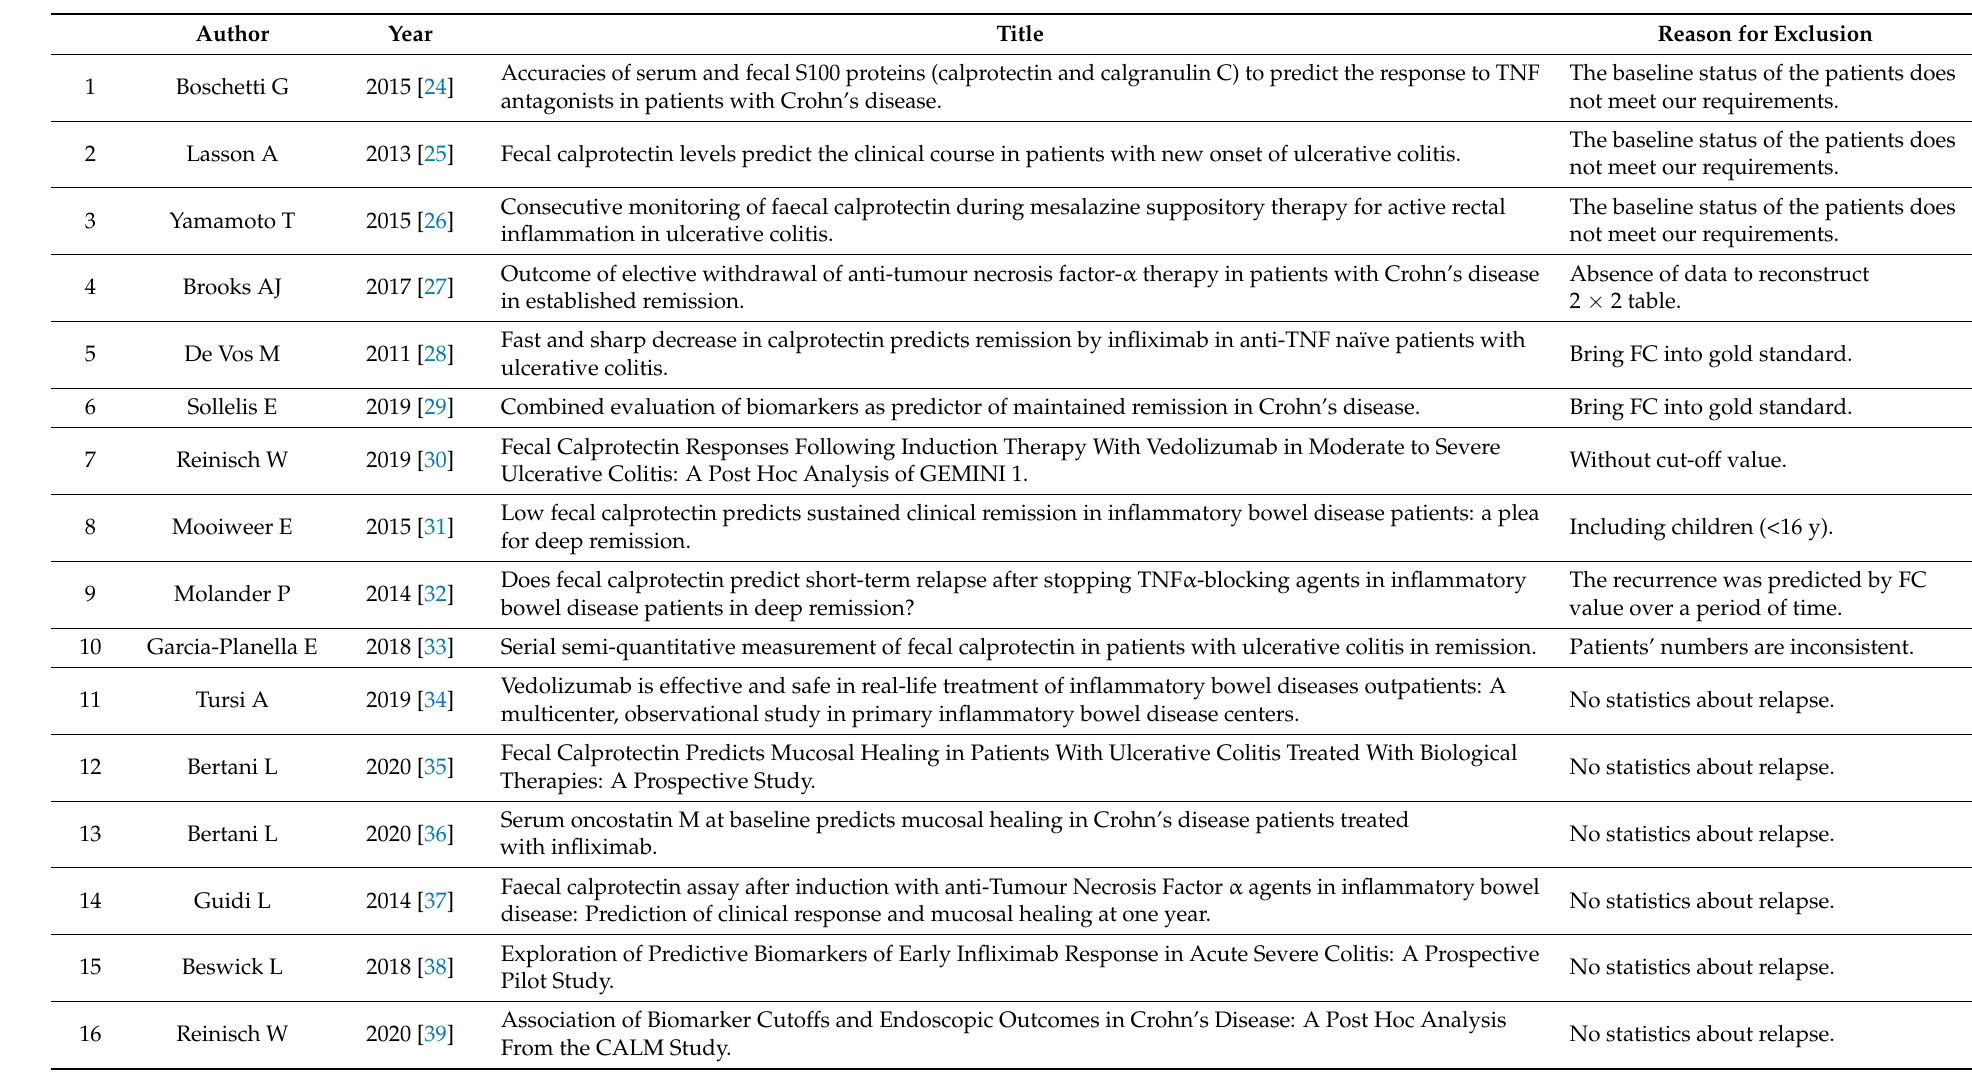
Table 1. List of excluded studies and reasons for their